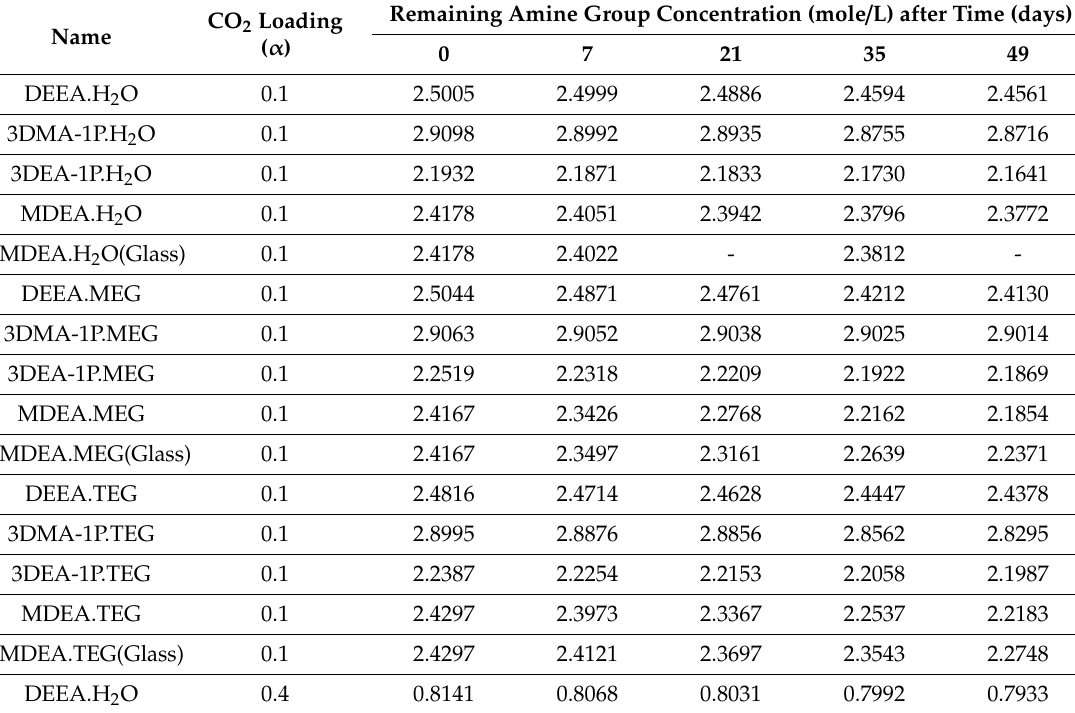
Table A1. Amine group concentrations in all